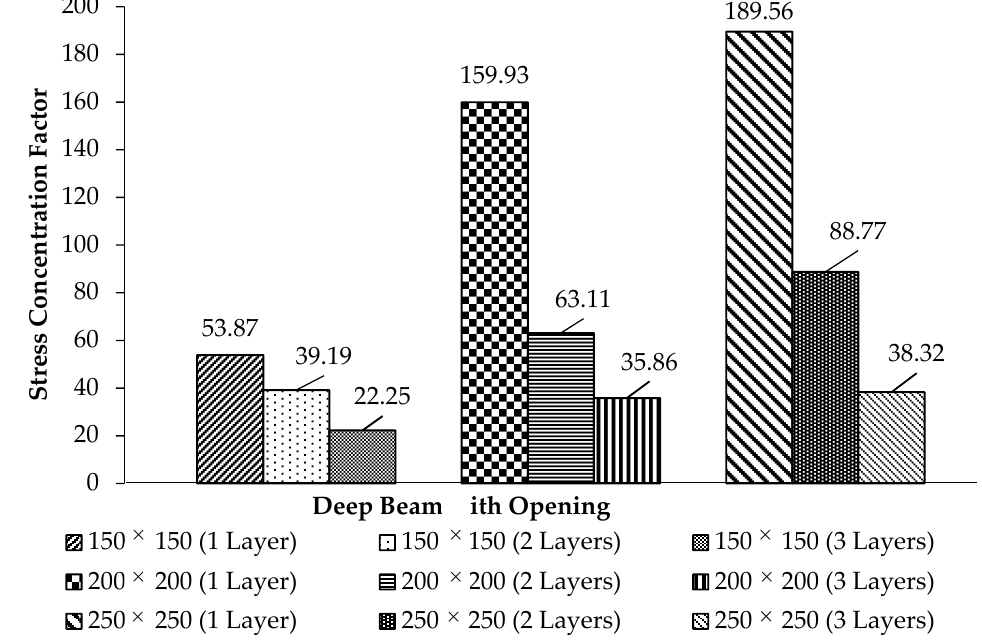
Figure 20. Flexural stress concentration factor (k).